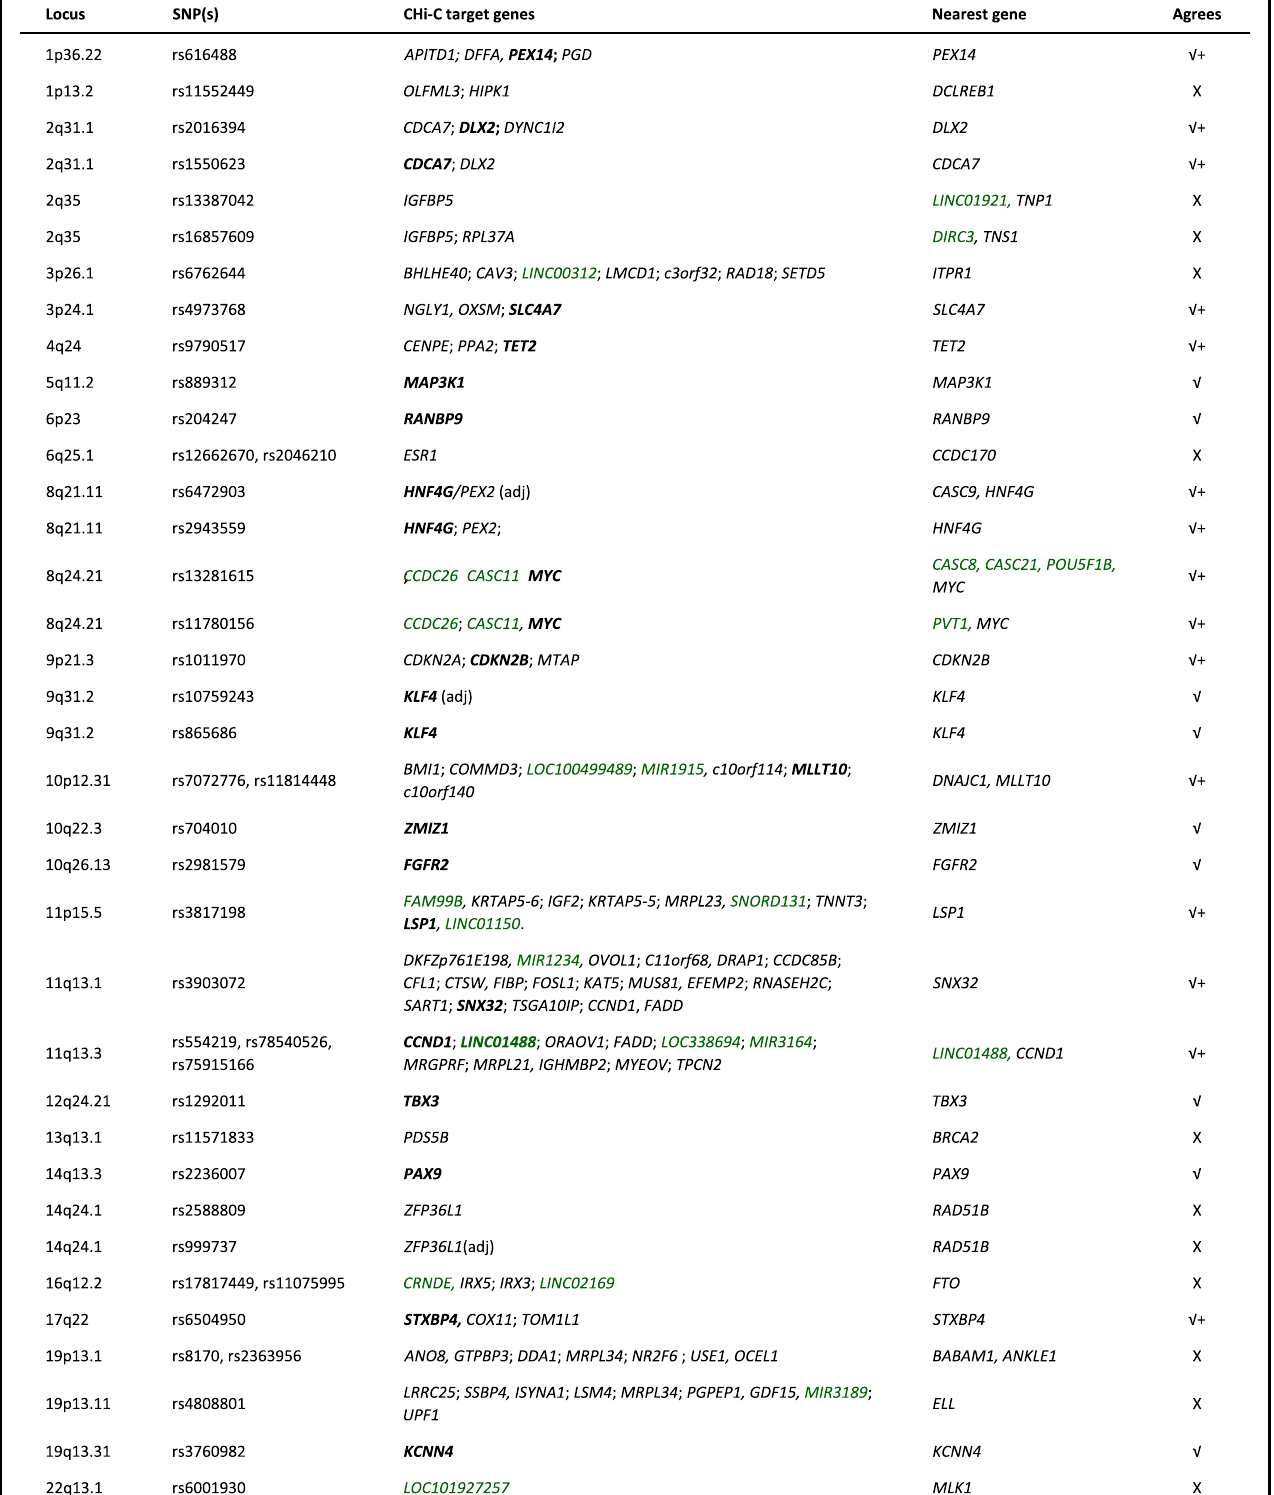
Where TSS for two or more target genes map to a single HindIII fragment, the genes are separated by a comma. Non-coding RNAs (long non-coding RNAs, microRNAs and small nucleolar RNAs) are indicated in green. There were three loci at which the target gene is assigned indirectly on the basis of interaction peaks with an adjacent locus; these are indicated by (adj). De fi ning nearest gene; for SNPsthatmapwithinagene(UTR,exonsorintrons)thisgeneisconsideredtobethenearestgene,forSNPsthatdonotmapwithinagene,nearestgeneisassignedbasedonthelocationof thenearest TSS according to RefSeq genes (GRCh37/hg19). Where the nearest gene is a non-coding RNA, the nearest protein-coding gene is also given. CHi-C target genes that are also the nearest gene are indicated in bold. CHi-C targets and the nearest gene are compared in the “ Agrees ” column; √ CHi-C data were consistent with the nearest gene being the sole target gene, √ + CHi-C data were consistent with the nearest gene being one of several target genes, X CHi-C data support a gene other than the nearest gene as a